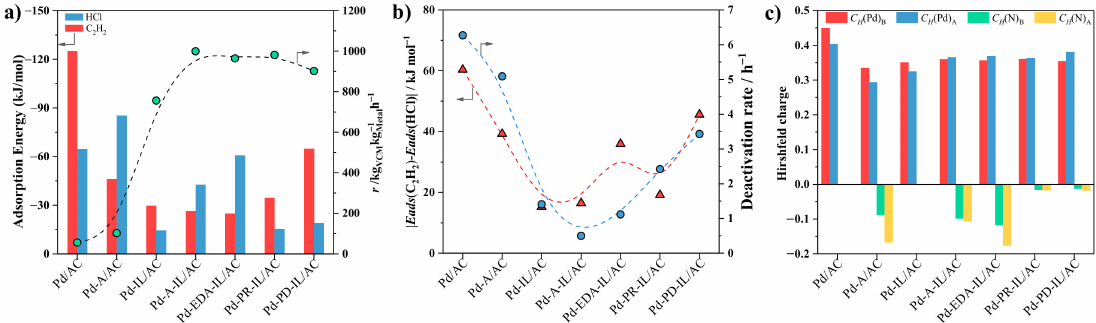
Figure 5. The molecular structure of the four nitrogen-containing ligands.